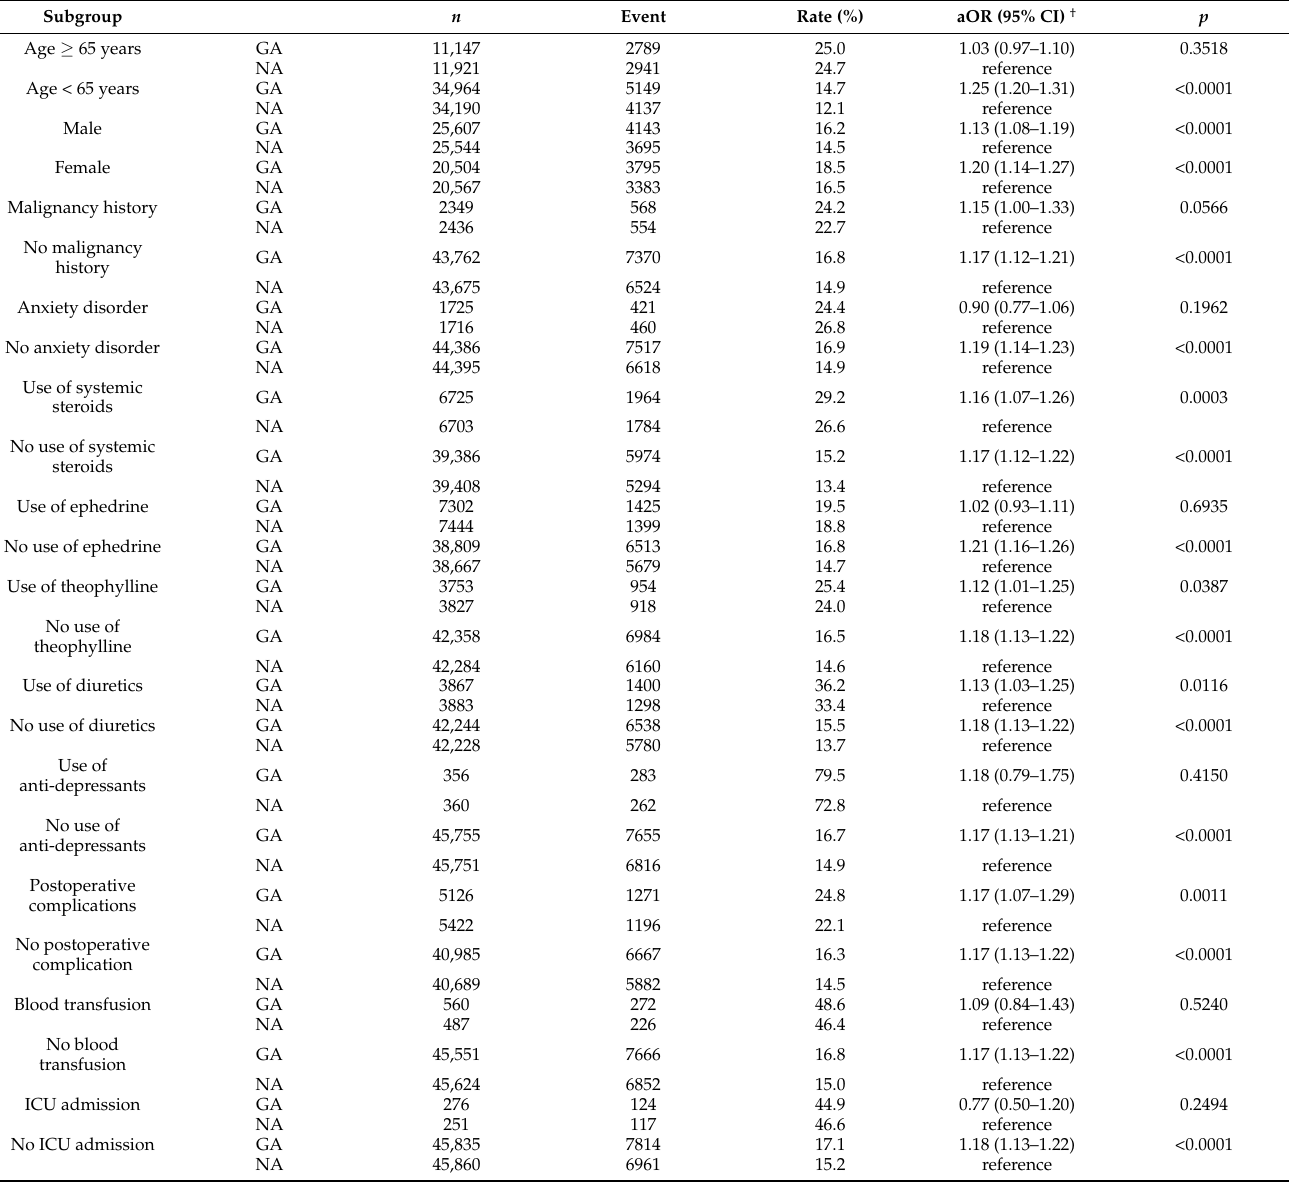
Table 4. Subgroup analyses of new postoperative uses of sedative–hypnotics for patients undergoing general or neuraxial